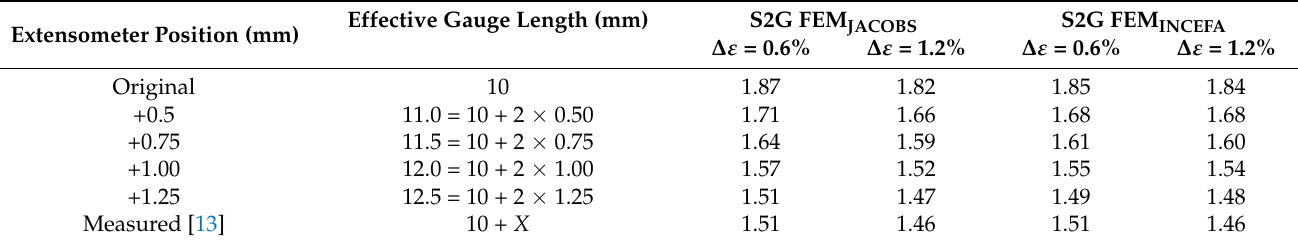
Figure 6. SCK-CEN specimen. Extensometer point positions (red dots). Table 6. S2G values for SCK-CEN specimen: extensometer position effect.